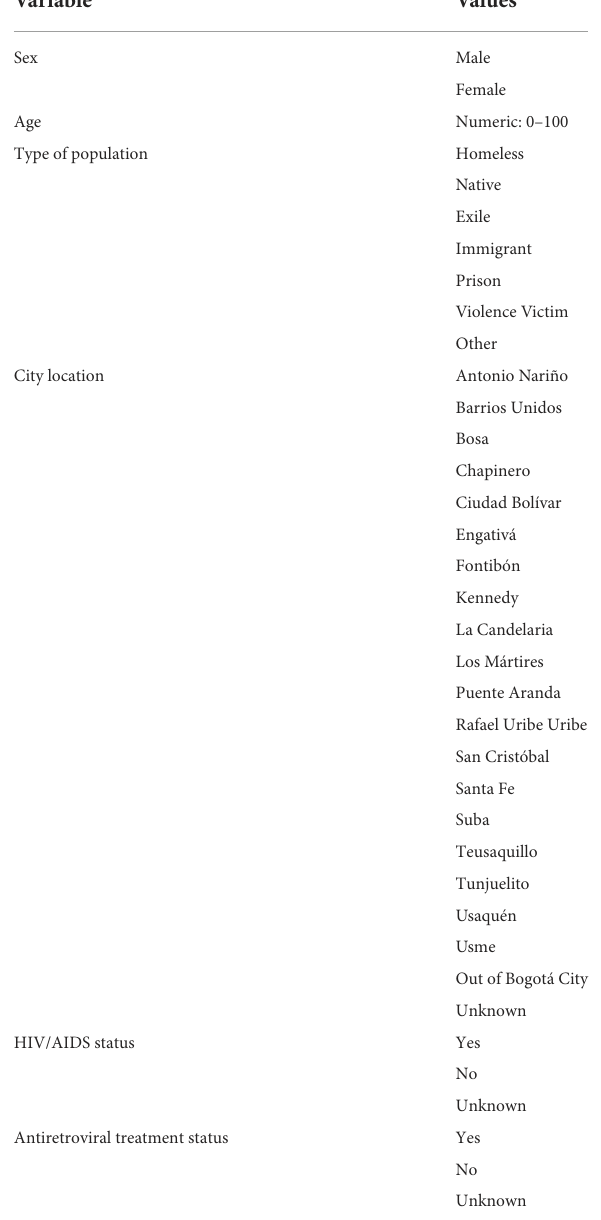
TABLE 1 Variables collected. Variable